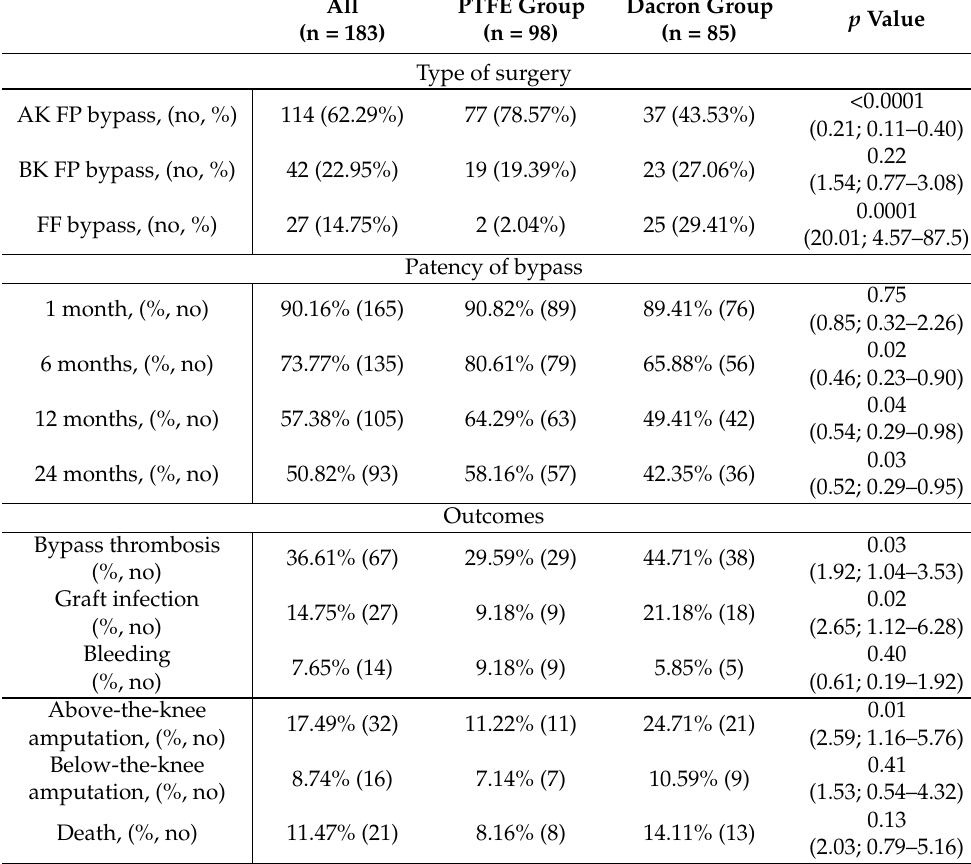
Table 3. Type of surgery, complications, and outcomes of all patients enrolled in the